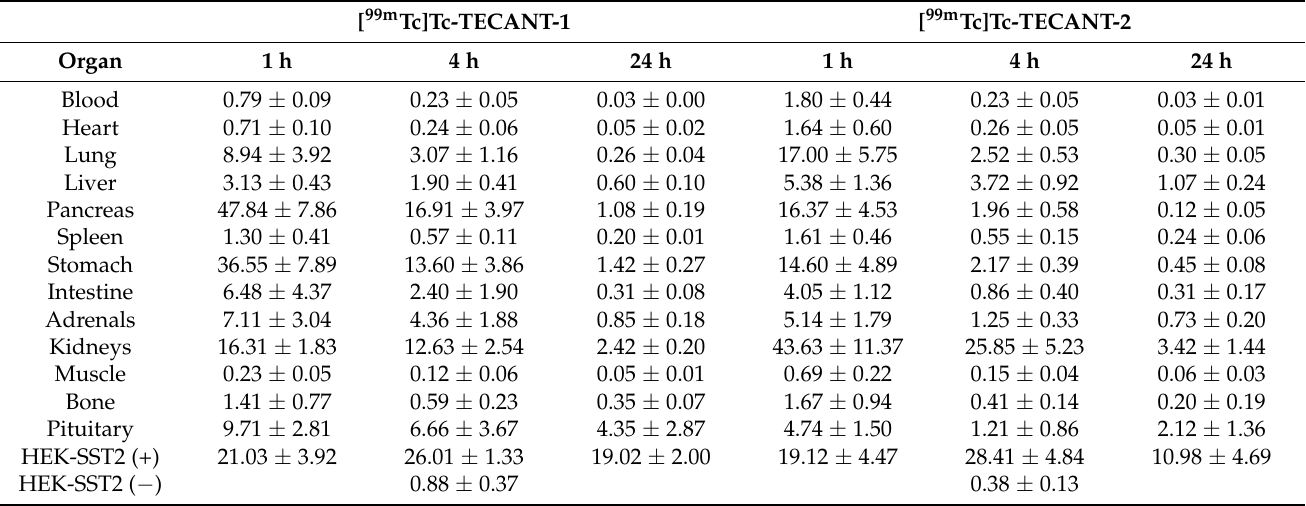
Table 2. Biodistribution results of [ 99m Tc]Tc-TECANT-1 and [ 99m Tc]Tc-TECANT-2 in nude mice bearing human embryonic kidney-293 (HEK293) cells transfected with the human SST2 (HEK-SST2) (positive) tumours. The cohort of 4 h post-injection (p.i.) included dual HEK-SST2 and HEK (SST2-negative) tumours. The results are expressed as %IA/g ± SD ( n =